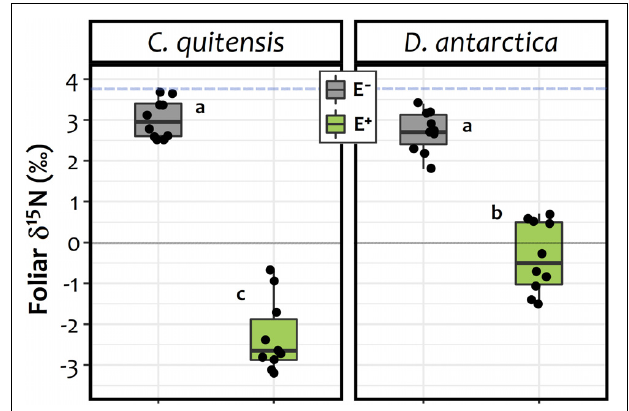
FIGURE 4 | d15N signatures observed on the foliar tissues of C. quitensis and D. antarctica growing without fungal endophytes (E − , in gray), or inoculated with their most abundant root endophyte (E+, in green). Dots represent individual values ( n = 10), while boxplots the data inter-quartilic distribution per group. Different letters imply significant differences ( p < 0.05) between treatments and/or species, as determined by the Tukey a-posteriori pairwise comparison test. The blue dashed line denotes the isotopic signature of the initial substrate (d15N = 3.7 ). The zero represent outcome among the enrichment / depletion of the 15N isotopic, relative to the standard (i.e., the (cid:104) atmospheric 15N/14N